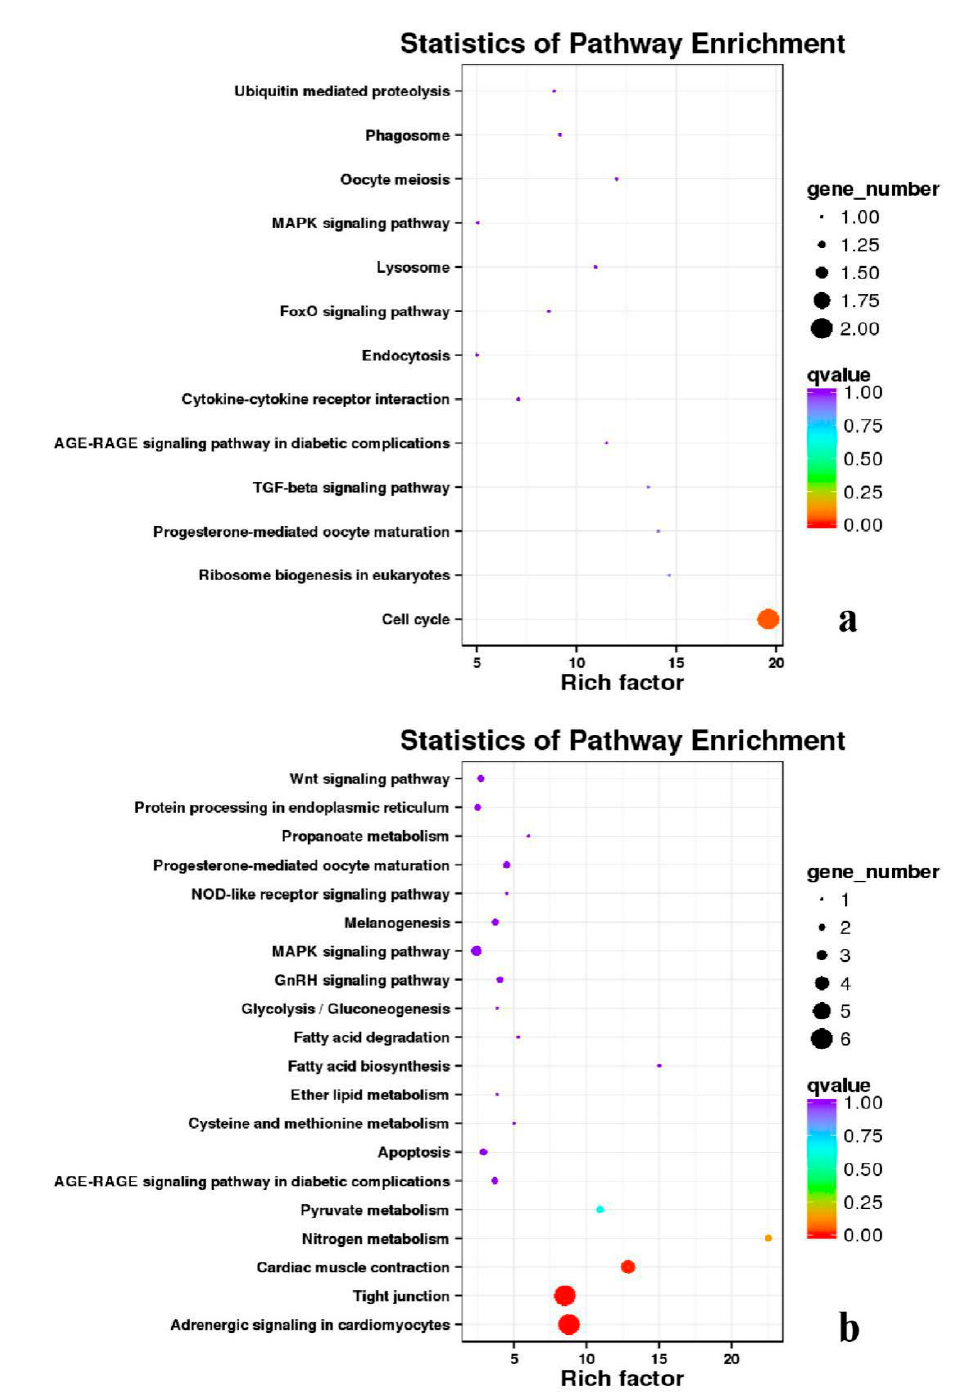
Figure 20. KEGG annotation of DEGs in the comparison of breast and leg muscle. ( a ) BE34B_vs_BE34L; ( b ) BM6B_vs_BM6L.